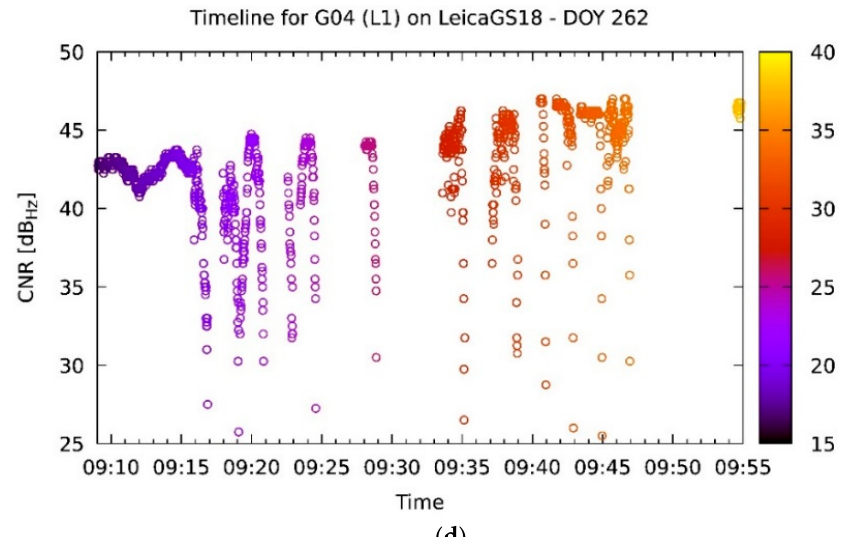
Figure 8 . Time development of CNR for different receivers and satellites with the color of the points representing the satellite elevation: ( a ) continuous acquisition on a smartphone; ( b ) typical acquisition on a geodetic device with many blank spots; ( c ) smartphone with some blank spots; and ( d ) acquisition on a geodetic device with unusually few (relative to geodetic devices) blank spots; the reasons could be multipath or non-line-of-sight due to vegetation. For other receivers, see https://gnss.fpp.uni-lj.si/2022-09-19 (accessed on 19 February 2022).